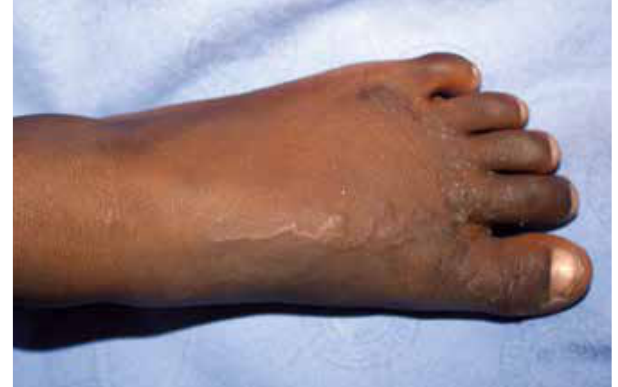
Figure 11: Cutaneous larva migrans Note the wandering, serpentine pattern